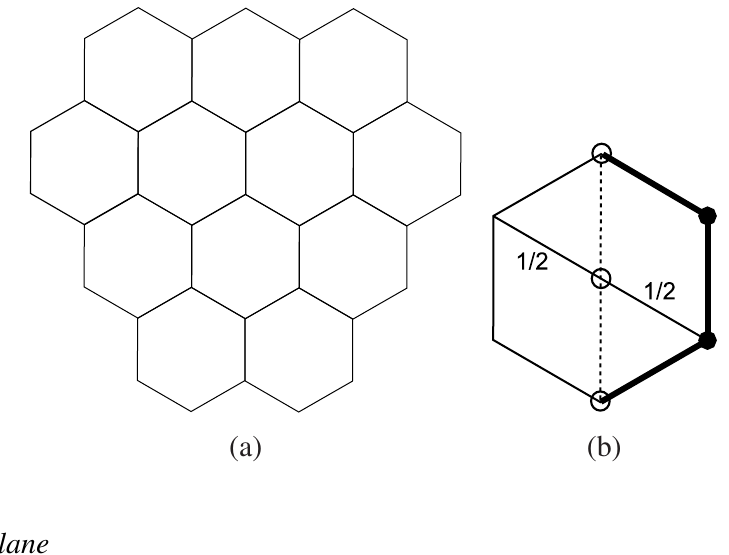
Figure 1 . (a) A part of the tiling of the plane into hexagons. (b) One hexagon of the tiling. The bold lines indicate the parts of its border that belong to this